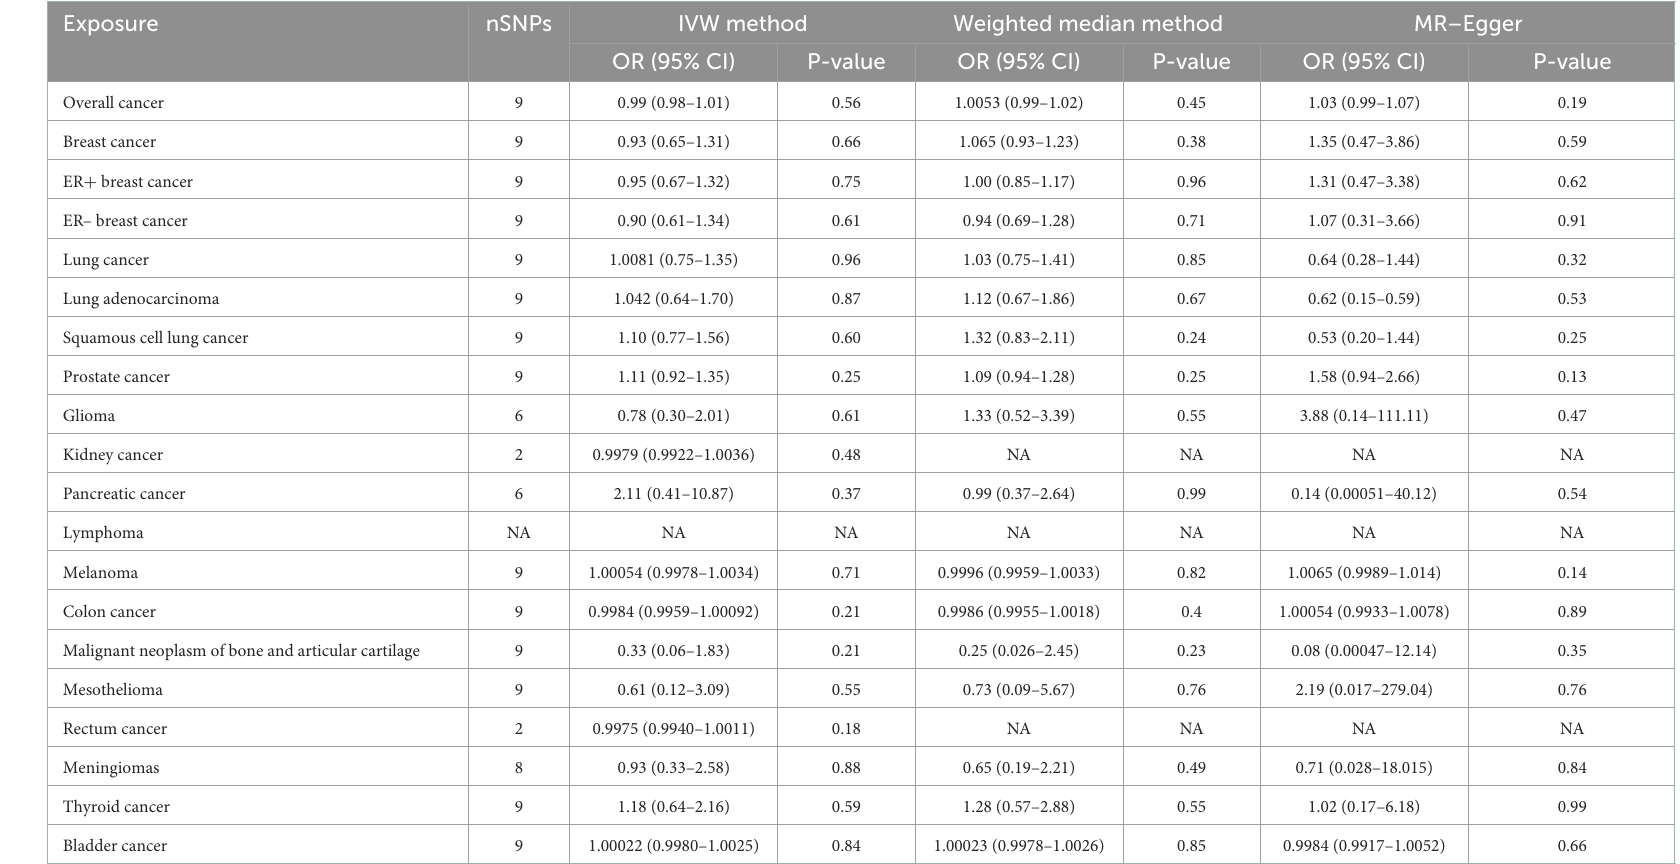
TABLE 3 Mendelian randomization estimates of the associations between heart failure and cancer risks.